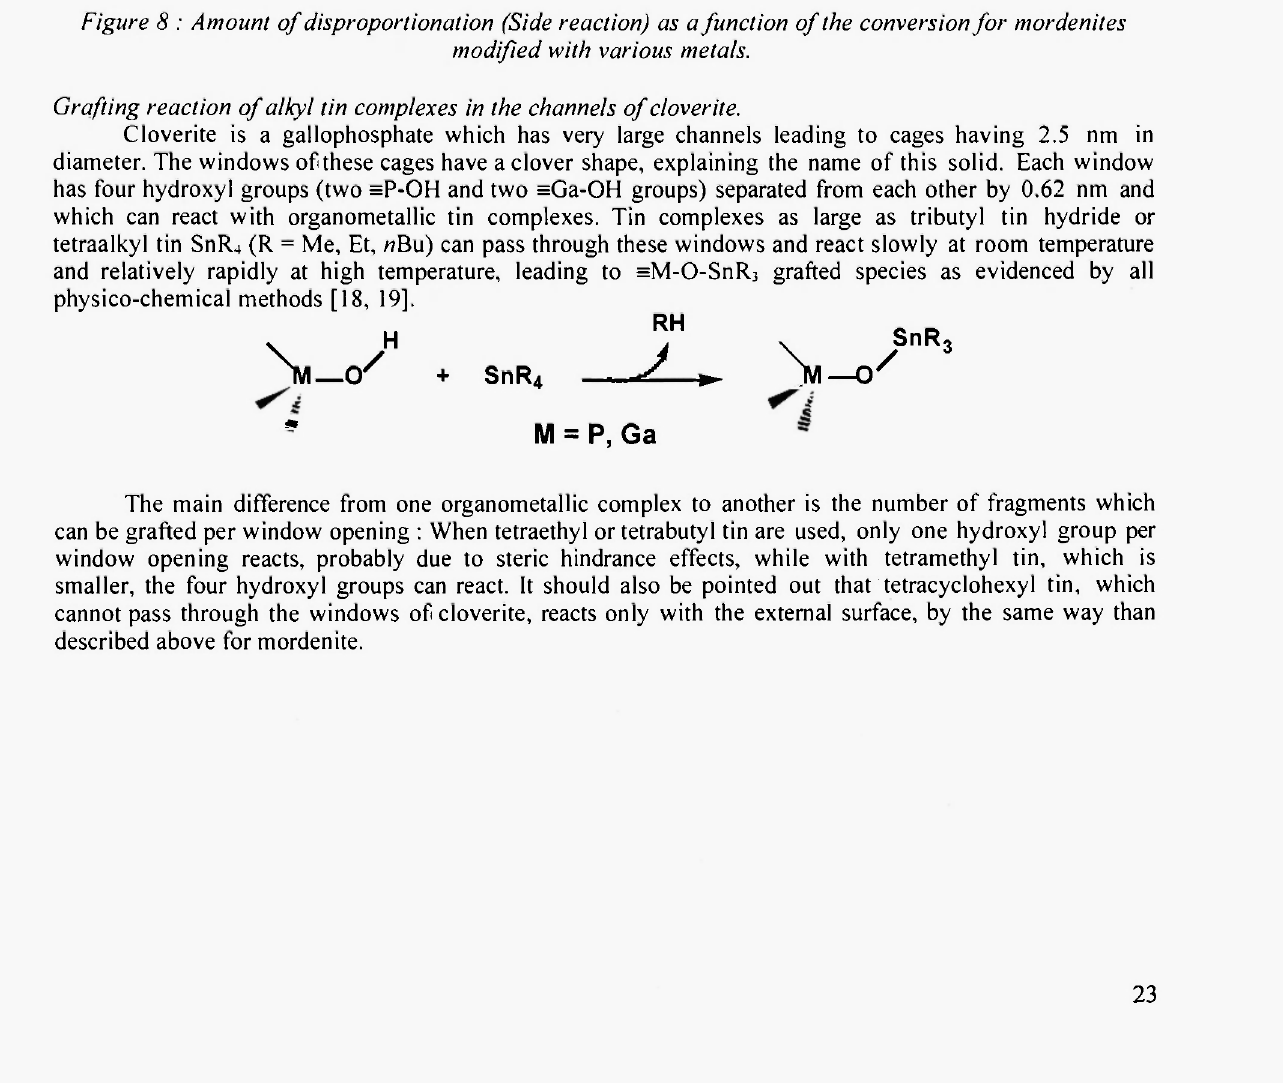
Figure 8 : Amount of disproportionation (Side reaction) as a function of the conversion for mordenites modified with various